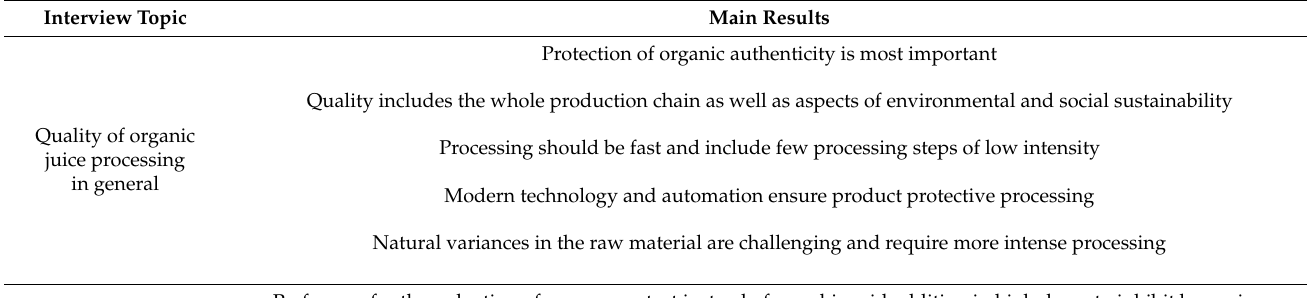
Table 3. Overview on the main results for each interview